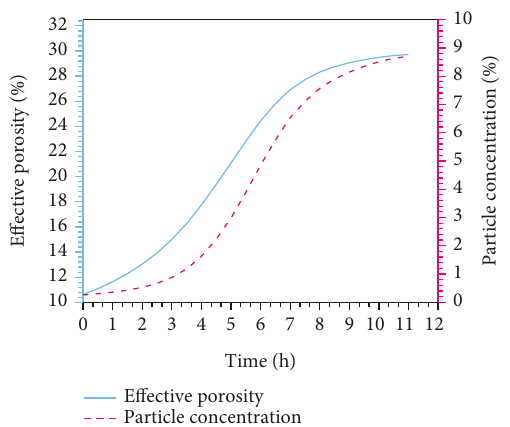
Figure 11: The average e ff ective porosity and particle concentration curves with time.